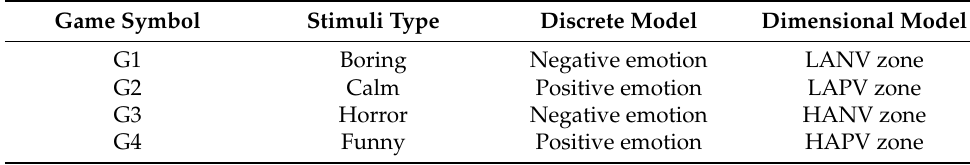
Table 1. The stimuli that used in the GAMEEMO data